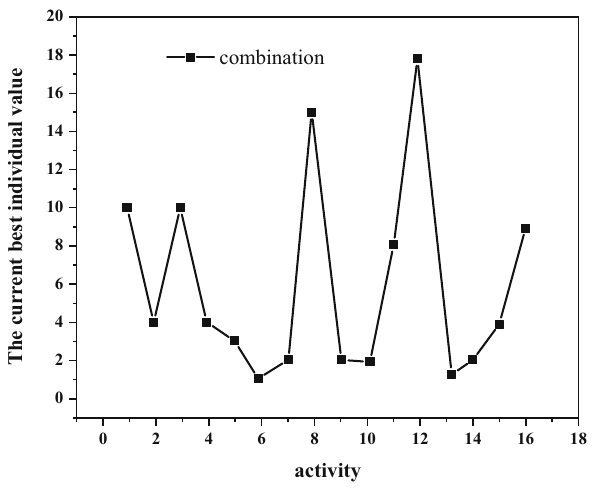
Figure 6: The best combination of current activities.